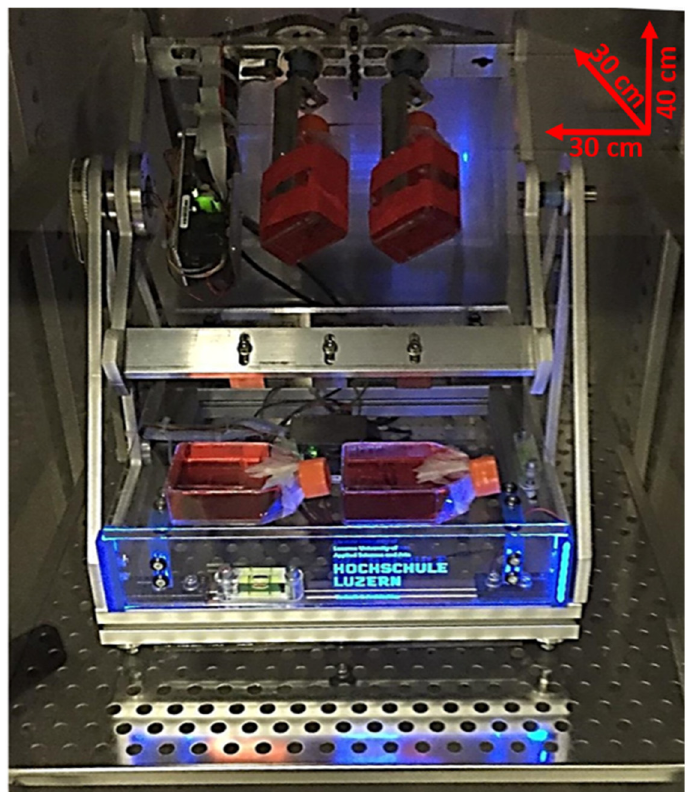
Figure 1. Image of the microgravity simulator (MGS) hosted in a CO 2 incubator. The dimensions are reported. The MGS is connected to a PC that runs a particular software based on a two-level software architecture approach to enable a wide range of applications: a first-level offline motion simulation for parameter identification and optimization for different targets and ranges of microgravity conditions, and a second-level drive control software using these optimized parameters in the microgravity simulator (MGS-hardware).